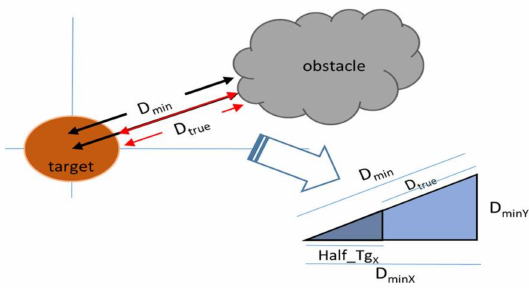
Figure 5. Calculating true distance (D true ) between the target and an